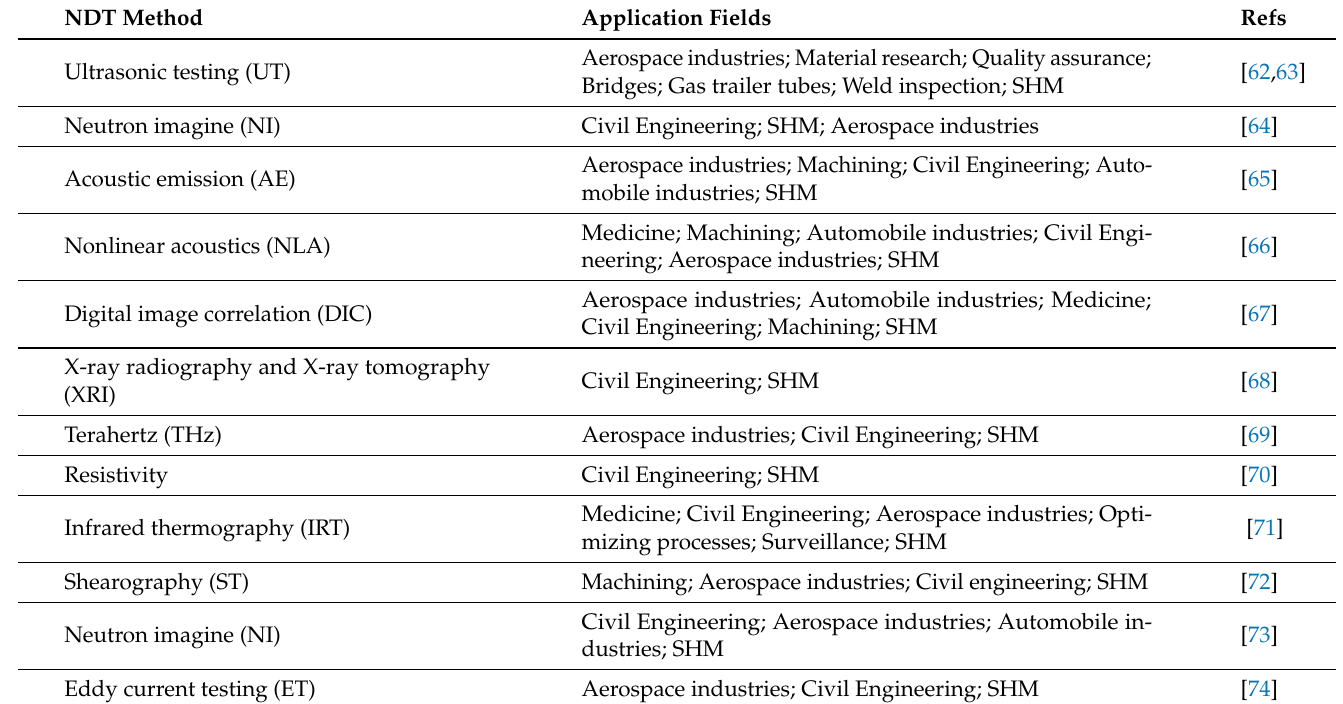
Table 4. Applications fields of various NDT